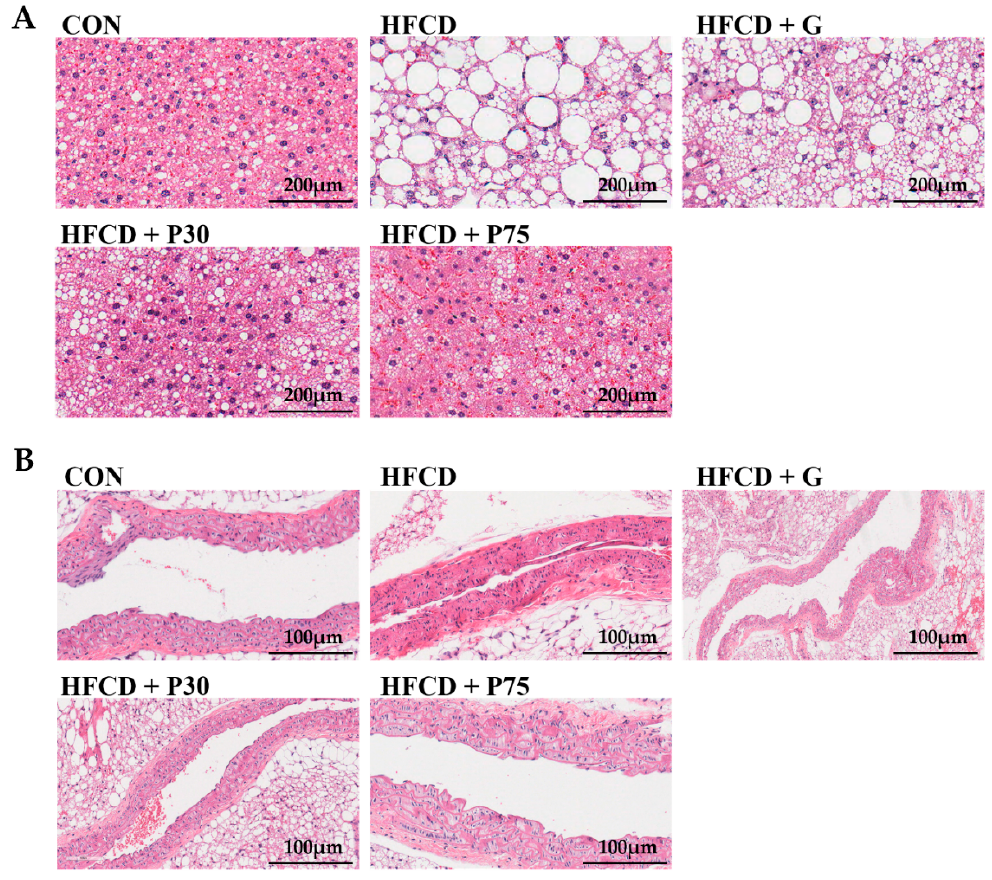
Figure 2. Effect of PEITC supplementation on the livers and aortas of mice: ( A ) Representative photomicrographs of hematoxylin and eosin (H&E) staining of liver tissue. The white areas in the hepatocytes are intracellular lipid droplets (magnification 200× g ) in H&E staining of formalin-fixed, paraffin-embedded sections; ( B ) H&E staining of aorta tissue (magnification 400× g ) in sections of formalin-fixed, paraffin-embedded tissue. CON: AIN-93G diet, HFCD: 60% calories from fat + 1% cholesterol, HFCD + G: HFCD + 3 mg/kg/day of GA, HFCD + P30: HFCD + 30 mg/kg/day PEITC, HFCD + P75: HFCD + 75 mg/kg/day PEITC.